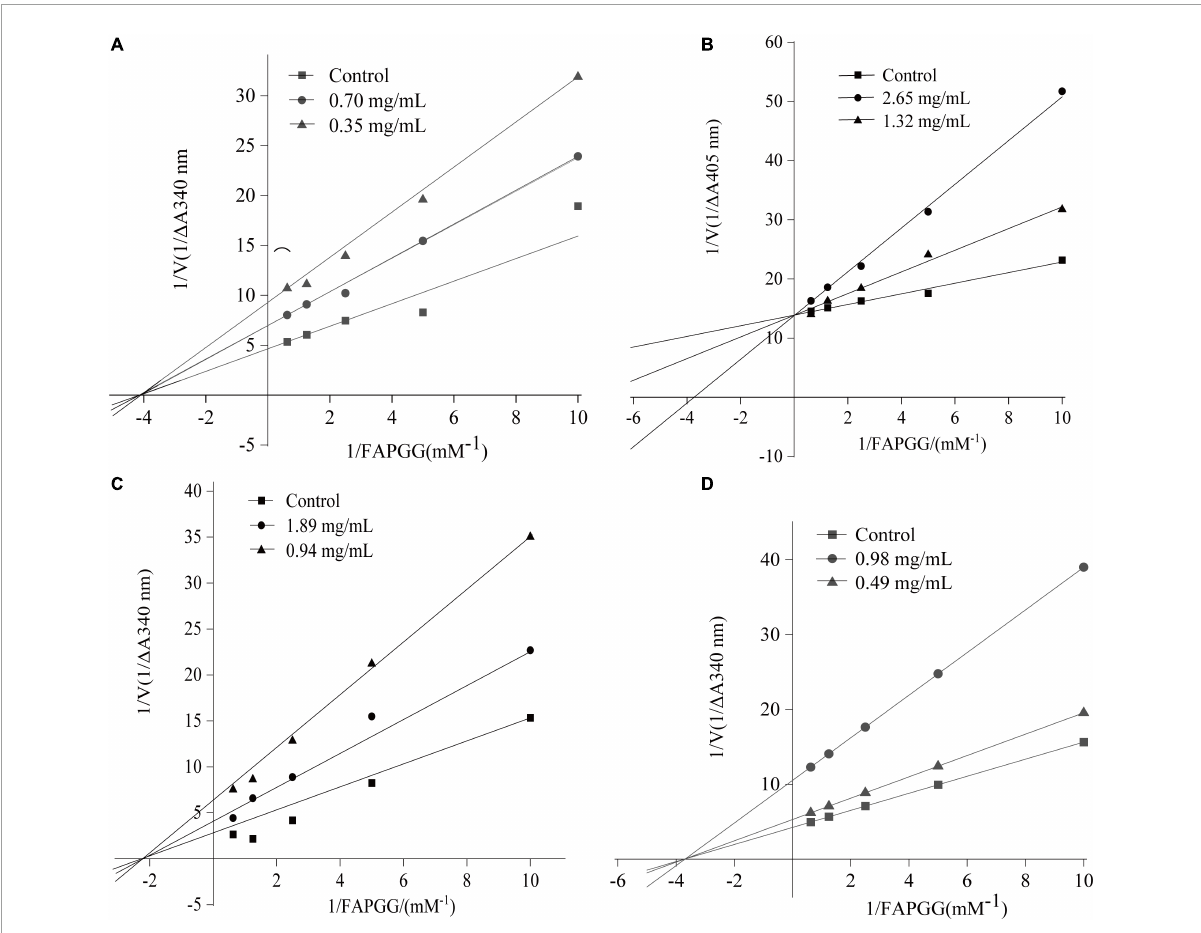
FIGURE9 Lineweaver–Burk plot of ACE inhibition by the peptides. (A) FDDKLD; (B) ERFNVE; (C) MELVLK; and (D) TELVLK.1/[S] and 1/[V] represent the reciprocal substrate concentration and velocity,